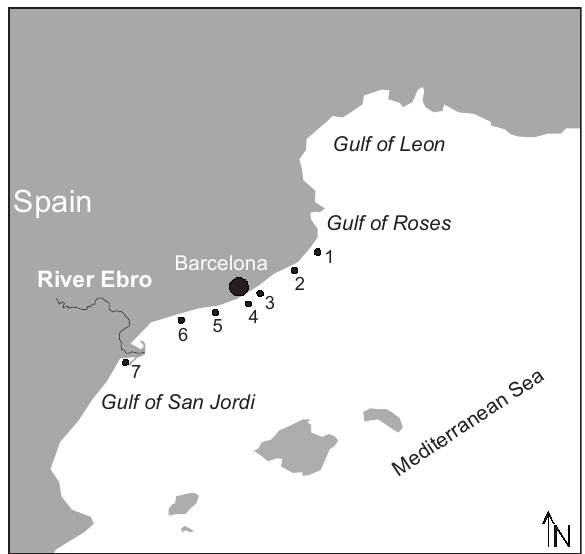
Fig . 1. – Geographic location of the study area and the sampling